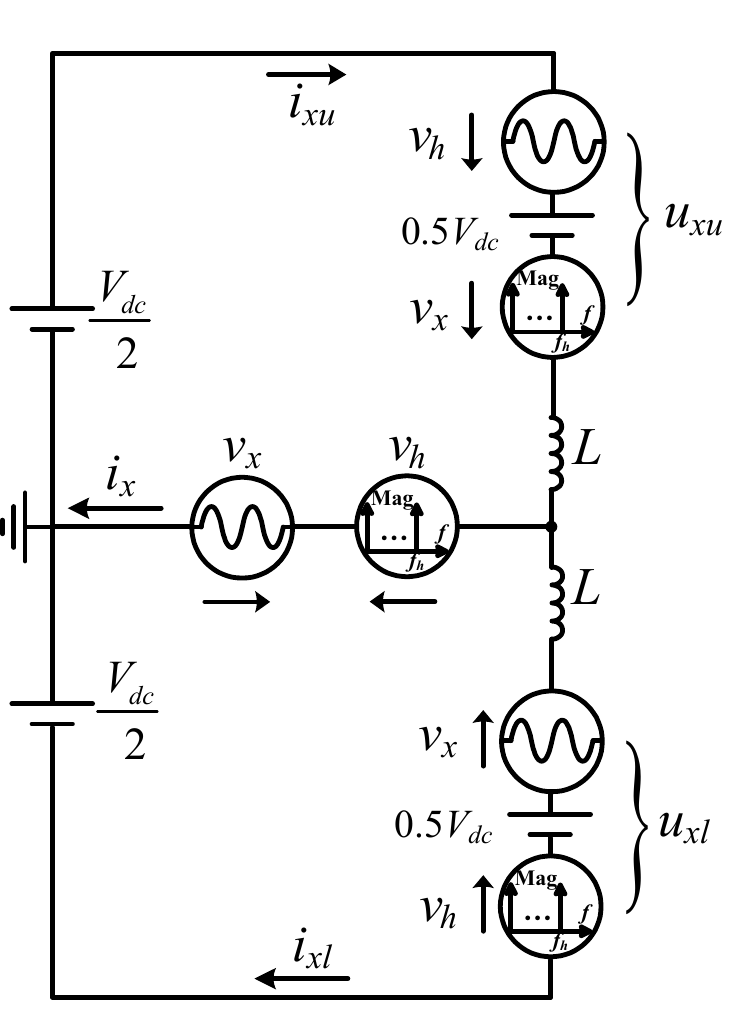
Figure 7. Equivalent circuit model of a single phase.